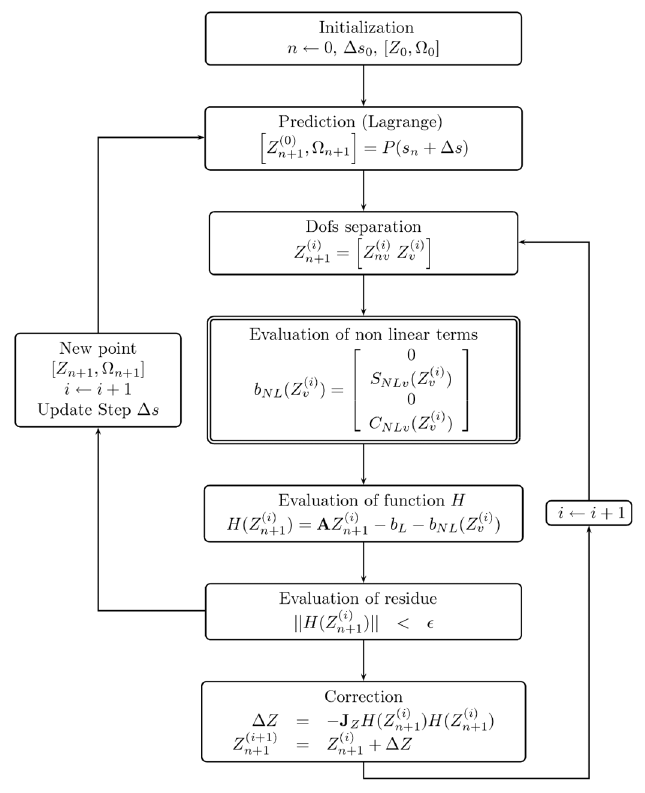
Fig. 1. Complete HBM algorithm with non term